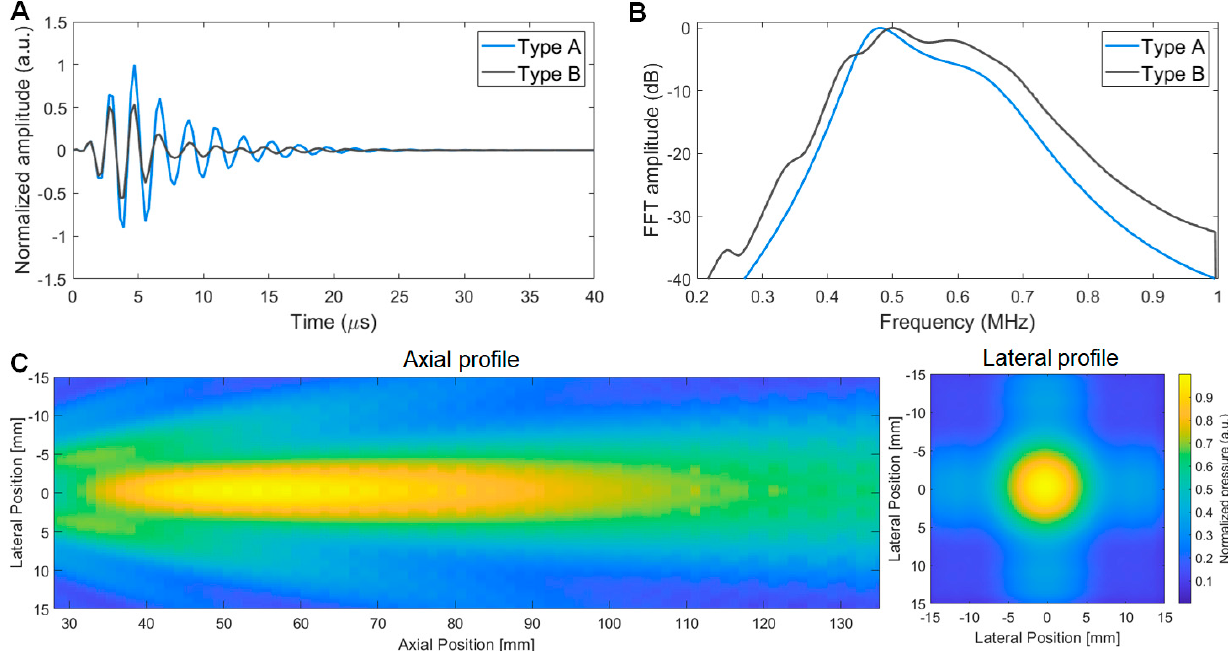
Figure 3. Simulation results: the PE waveform ( A ) and frequency spectra ( B ) of both type A (air − backing) and type B (heavy − backing) transducers, and the beam profile in axial ( left ) and lateral ( right ) planes ( C ).